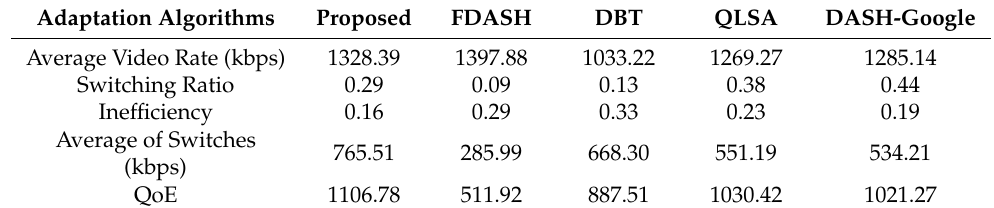
Table 5. Performance of algorithms at a buffer size of 30 s and a segment duration of 4 s. Adaptation Algorithms